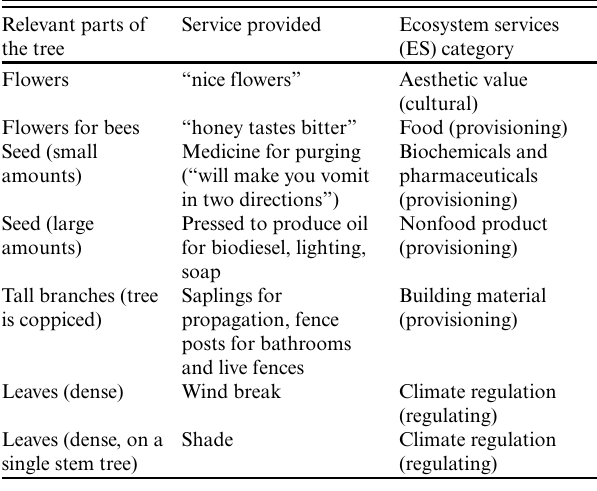
Table 2 . Observed traditional uses of Jatropha curcas : the services provided by key parts of a single